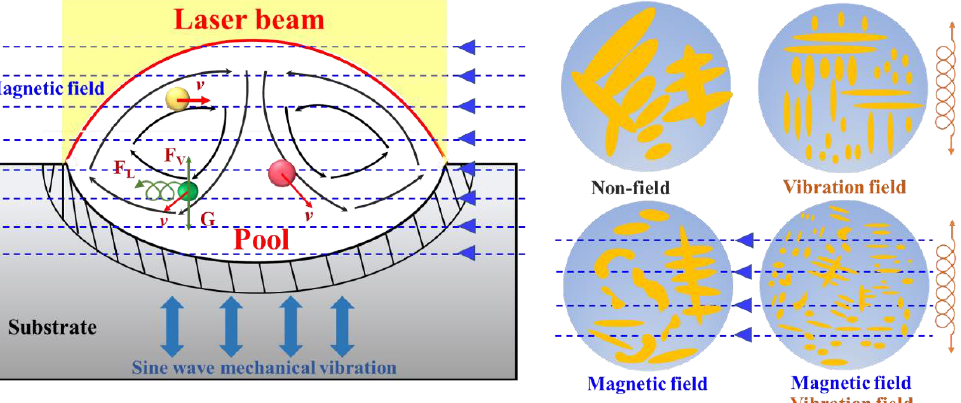
Figure 7. The mechanism of the effect of grains in laser cladding coating caused by different field- assisted types.